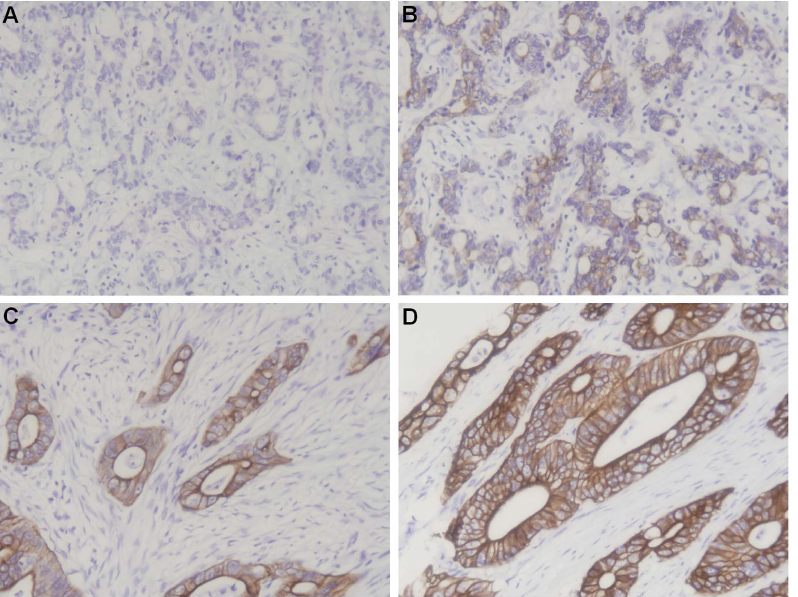
Figure 1. Immunohistochemistry staining pattern of CD147 in gastric cancer ( 6 200). A Negative staining ( 2 ) of CD147 in gastric cancer; B Weak positive staining ( + ) of CD147 in gastric cancer; C Moderate positive staining ( ++ ) of CD147 in gastric cancer; D Strong positive staining ( +++ ) of CD147 in gastric cancer. CD147 expression in gastric cancer could be an independent predictor of disease-free survival for patients, indicating that patients with positive CD147 staining have a higher risk of relapse than those with negative staining. In addition, TNM stage was also a prognostic factor for disease-free survival in multivariate analysis.